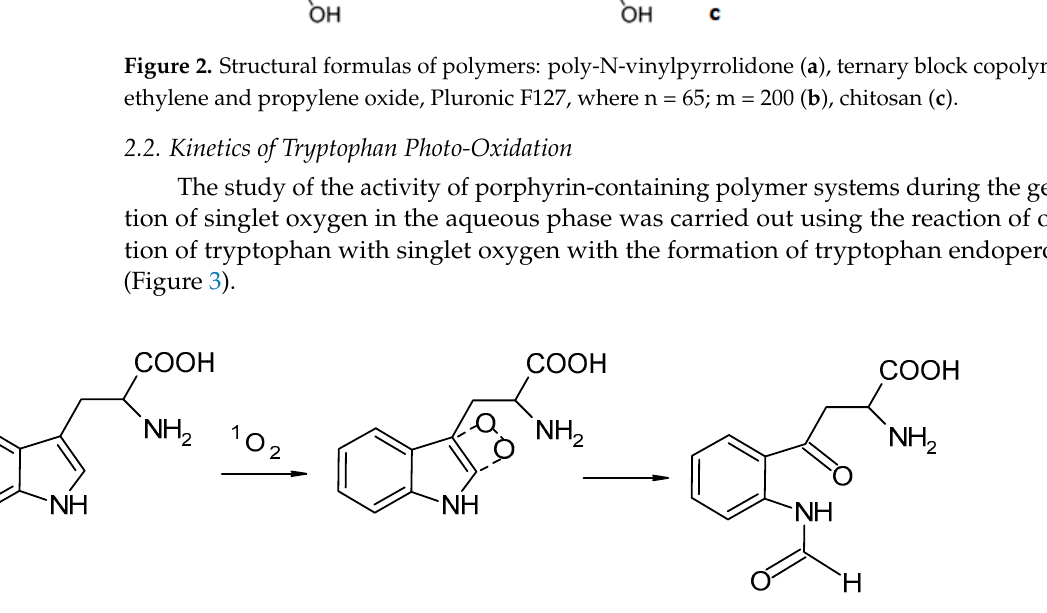
Figure 3. Reaction of oxidation of tryptophan with singlet oxygen.